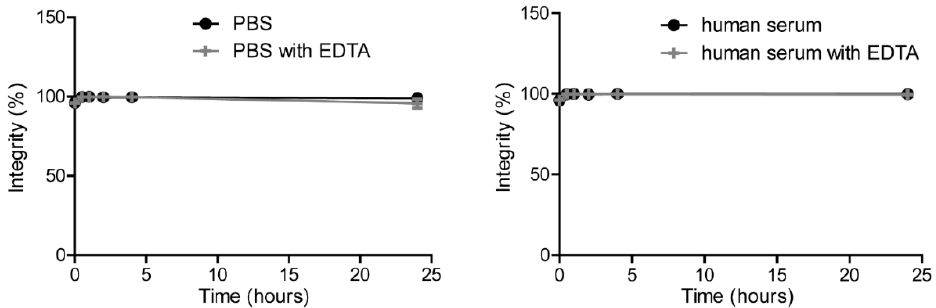
Figure 3. Stability of [ 111 In]In-DTPA-IRDye700DX-7D12 in PBS (left graph) or human serum (right graph) in presence or absence of 1000-fold molar excess EDTA.